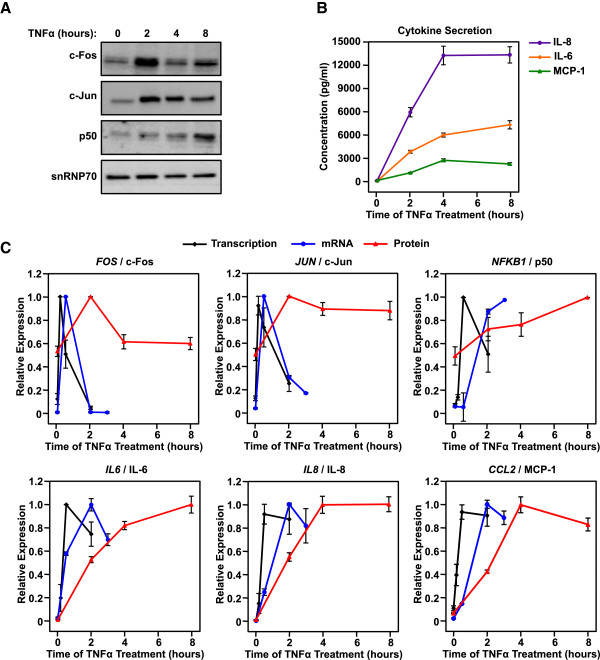
TNFα induced transcriptional responses in AC16 cardiomyocytes result in corresponding changes in mRNA and protein levels with similar, but delayed, kinetics. A) Western blots of c-Fos, c-Jun, the NF-κB p50 subunit, and snRNP70 (a loading control) from whole cell extracts of control and TNFα-treated AC16 cells (25 ng/ml of TNFα for the indicated treatment times). The assays were repeated three times. B) Scatter plots showing the concentration of secreted cytokines determined using a Bio-rad Bio-Plex cytokine assay, including IL-6, IL-8, and MCP-1 as indicated in control and TNFα-treated AC16 cells (25 ng/ml of TNFα for the indicated treatment times). Each data point represents the mean ± SEM for three independent biological replicates. C) Scatter plots showing the level of transcription (by GRO-seq), mature mRNA (by RT-qPCR), and protein (by Western blotting or Bio-Plex cytokine assay) for FOS, JUN, NFKB1, IL6, IL8, and CCL2, as indicated, in control and TNFα-treated AC16 cells (25 ng/ml of TNFα for the indicated treatment times). Each data point represents the mean ± SEM for two (GRO-seq) or three (RT-qPCR, Western, Bio-Plex cytokine assay) independent biological replicates.